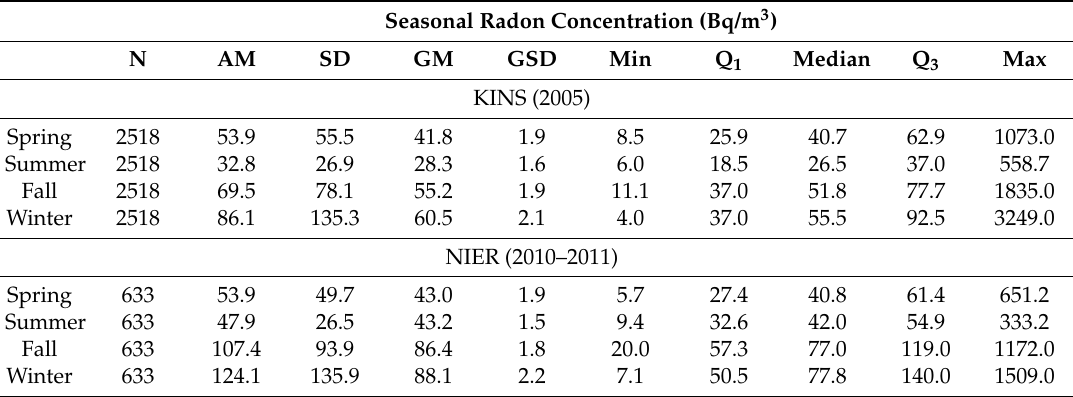
Table 1. Indoor radon concentrations in the Korea Institute of Nuclear Safety (KINS) and National Institute of Environmental Research (NIER) surveys for each season.